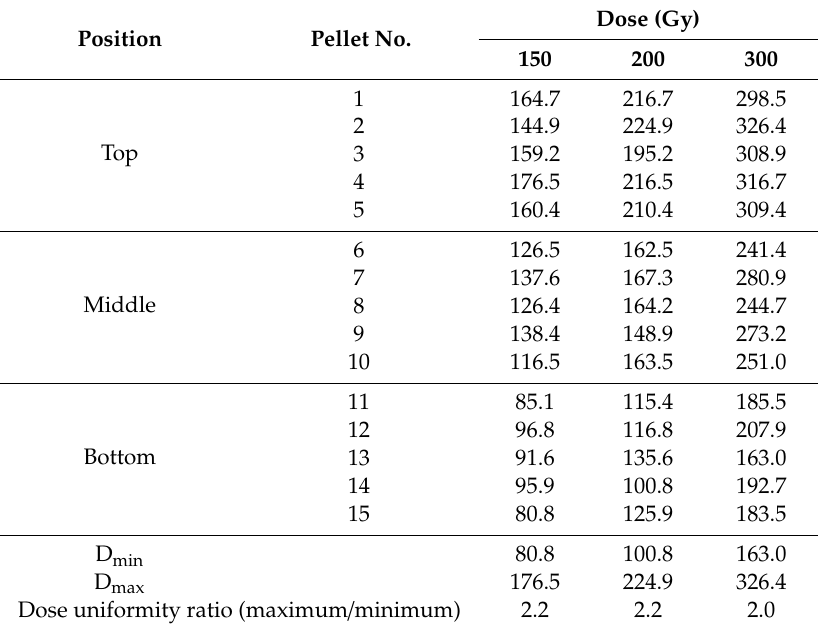
Table 4. Dose mapping of electron beam in boxes filled with strawberry fruits. Position Pellet